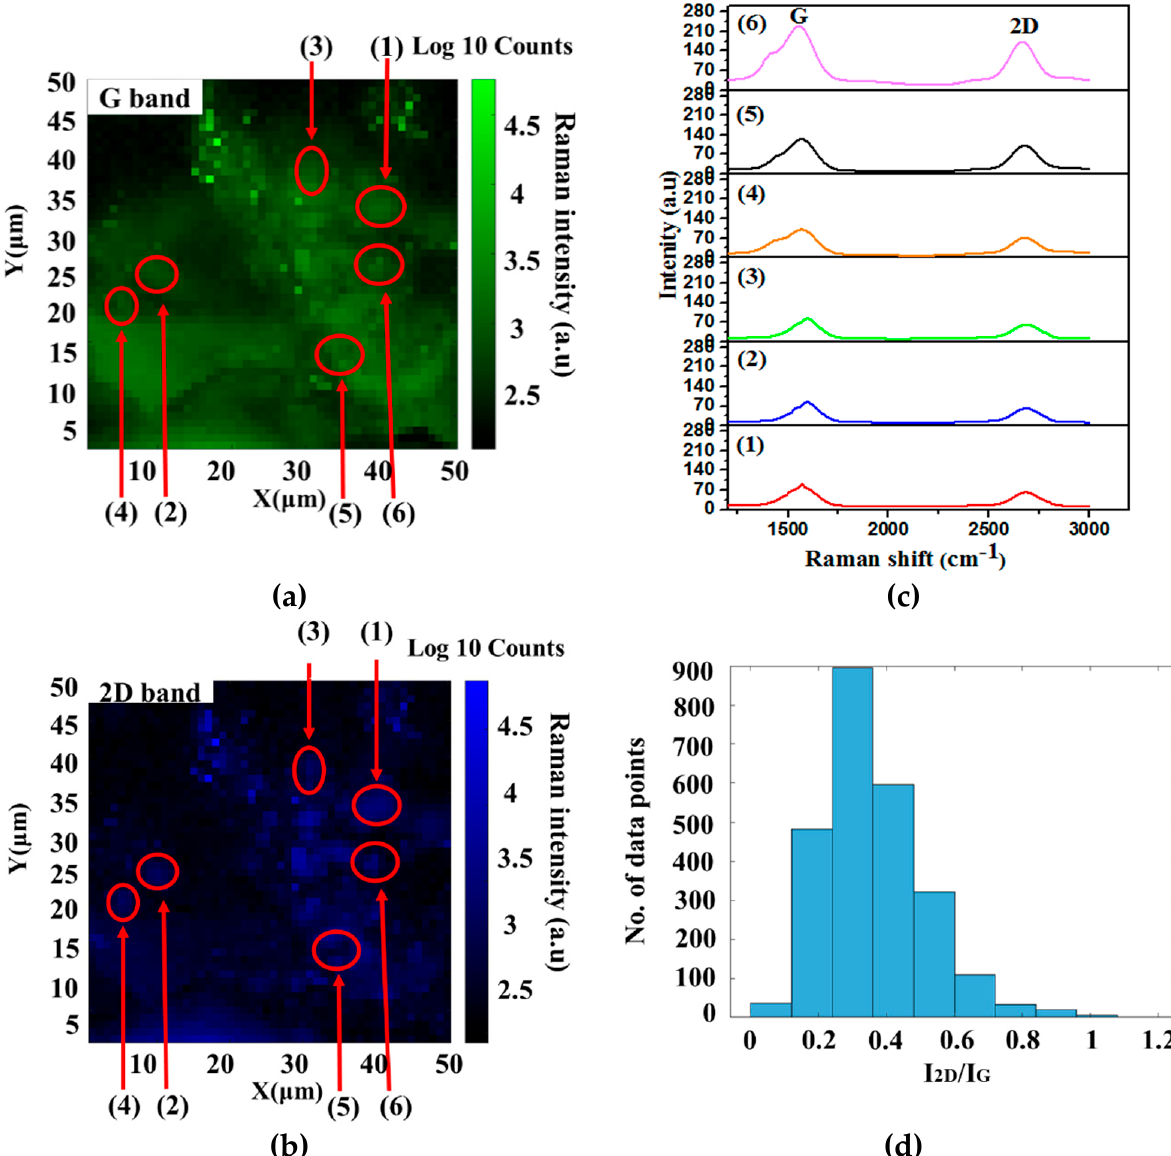
(b) Figure 5. (a) AFM image and (b) corresponding line profile of the P10% Fe sample.